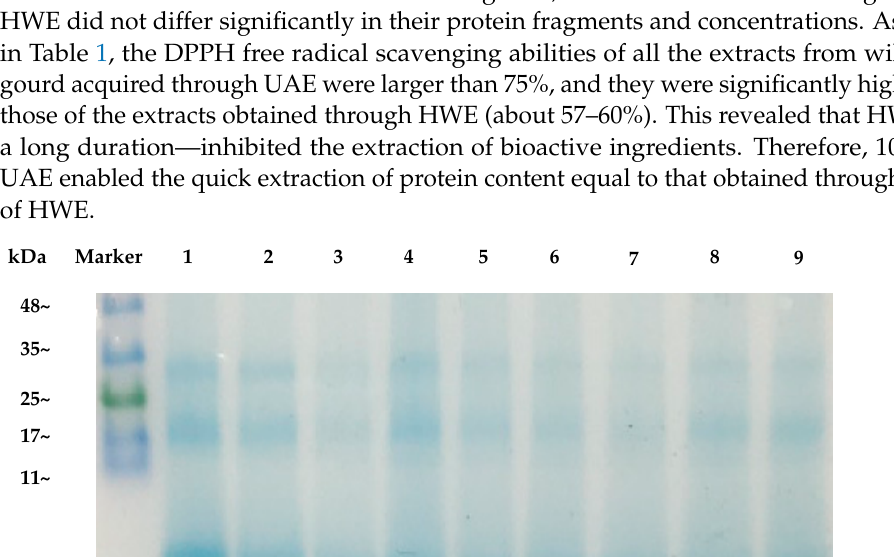
Figure 1. SDS-PAGE of protein from wild bitter gourd extract under different extraction sterilization conditions. Lane 1–3: ultrasonic extraction (UAE); Lane 4–6: hot water extraction (HWE); Lane 1: 1:20, 10 min; Lane 2: 1:15, 10 min; Lane 3: 1:10, 10 min; Lane 4: 1:20, 60 min; Lane 5: 1:15, 60 min; Lane 6: 1:10, 60 min; Lane 7: extract; Lane 8: extract + 121 °C, 15 min; Lane 9: extract + HPP.